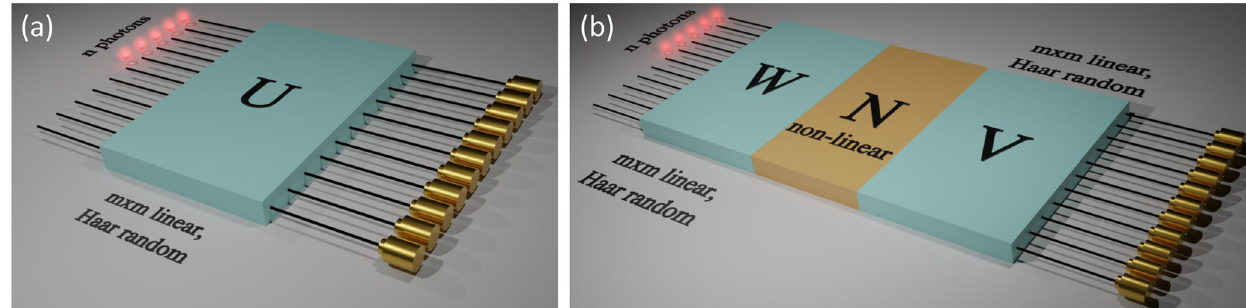
Fig. 1 Non-linear Boson Sampling. a Scheme for a Boson Sampling apparatus according to the original formulation 7 , where n input photons impinge in a linear network described by unitary matrix U . b Scheme for non-linear Boson Sampling, which includes a non-linear evolution step N between two Haar-random linear steps W and V